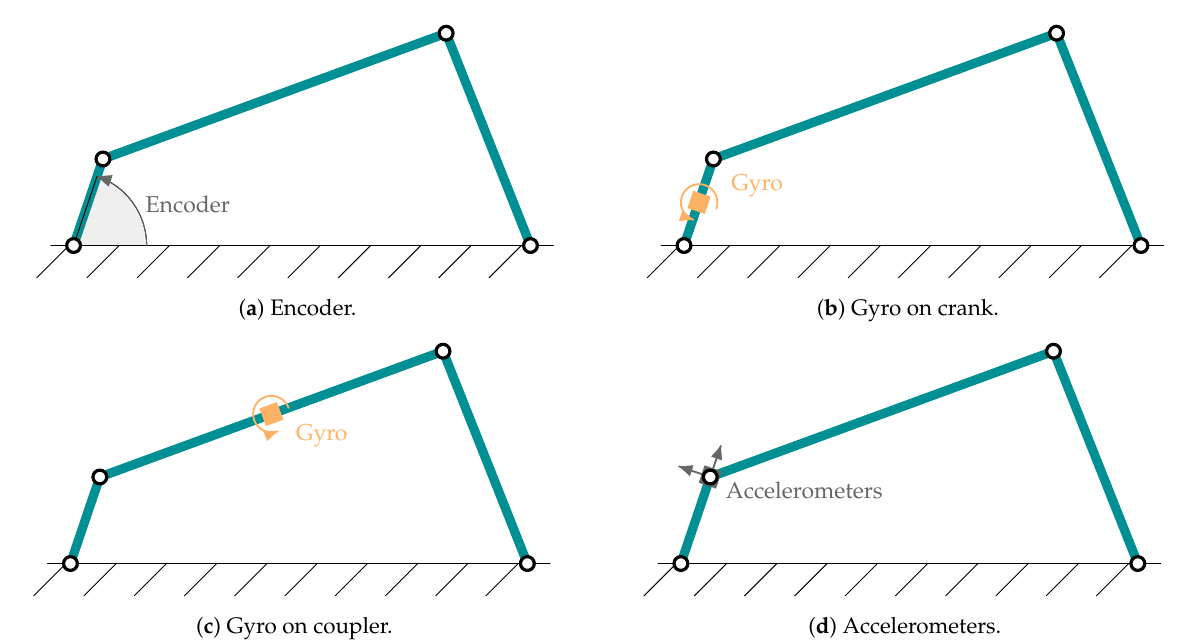
Figure 3. Sensor configurations considered in the four-bar